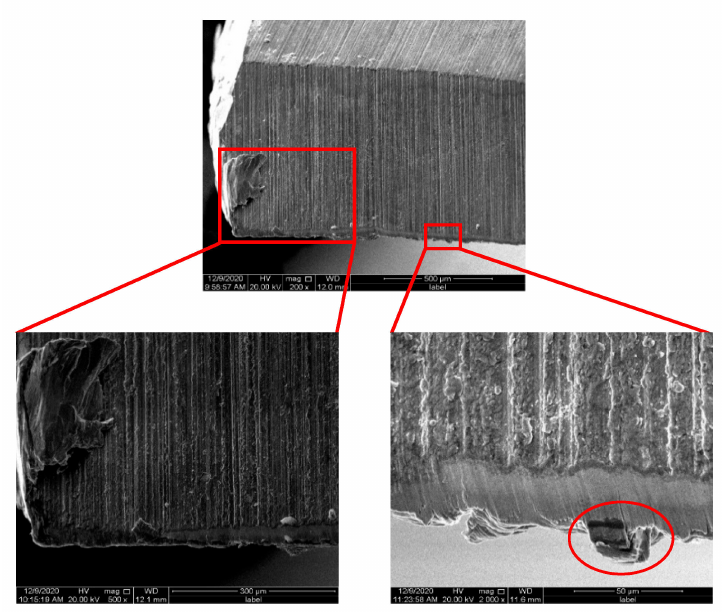
Figure 10. Wear morphology of rear edge of main cutting edge of coated